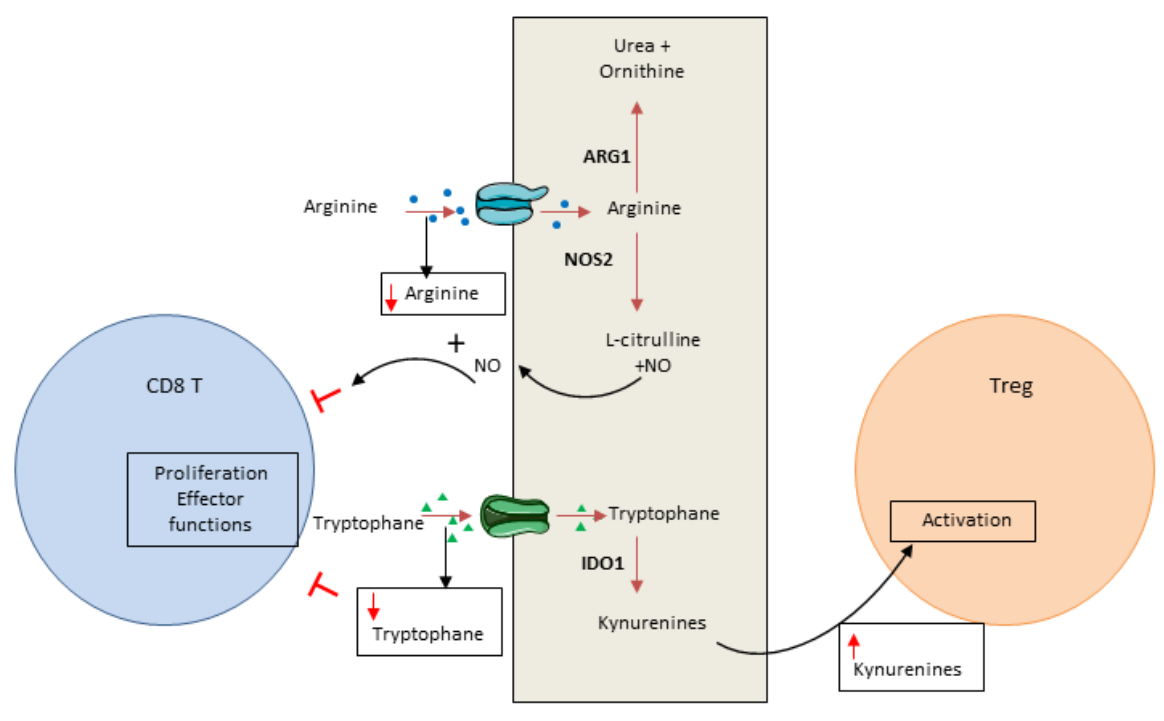
FIGURE 2: Amino acid consumption by cancer cells promotes immunosuppression. Cancer cells deplete essential amino acids for T cell activity leading to a decrease of their antitumoral function. For instance cancer cells import arginine that will be metabolized in Urea by Arginase 1 (ARG1) or in L-citruline + Nitric oxide (NO) by Nictric oxide synthase 2 (NOS2). The diminution of Arginine within the tumoral microenvironment as well as the production of NO by the cancer cells are inhibitor of T cells. The diminution of tryptophan in the tumoral microenvironment will also inhibit T cell. Moreover, the increase in kynurenine (tryptophan metabolite produced by IDO) will promote Treg cell